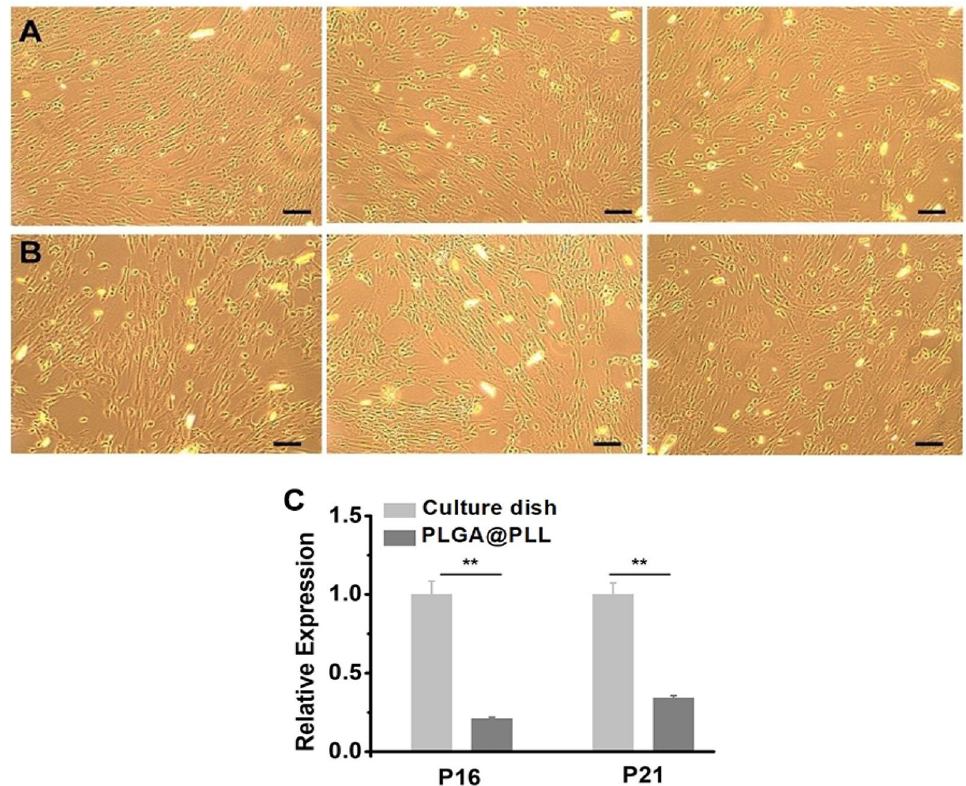
Fig. 3 Cell senescence was analyzed by β-galactosidase staining and RT-qPCR. A native hUC-MSCs from Wharton’s jelly and B hUC-MSCs released from PLGA@PLL scaffold. After β-galactosidase staining, all samples were observed under a microscope and displayed in three random regions. C Expression levels of the key cellular senescence genes P16 and P21 among the control and the scaffold groups were compared. The real-time PCR data were normalized to the internal control β-actin and plotted ( n 5). **indicates p < 0.01, two-tailed t -test Scale bar: 100 =